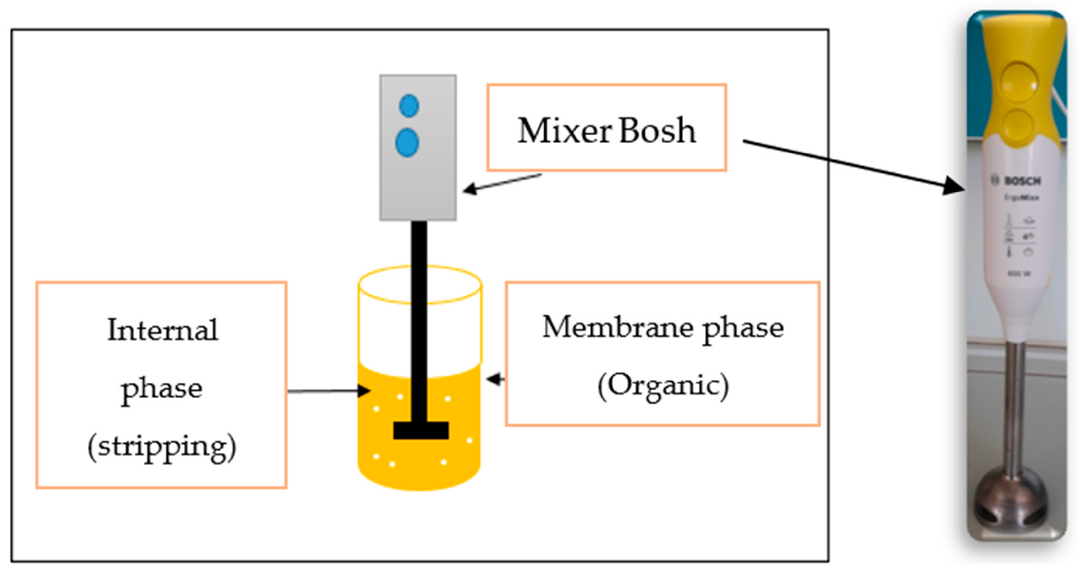
Figure 1. Emulsion